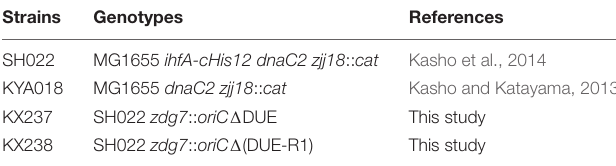
TABLE 1 | list of E. coli strains.